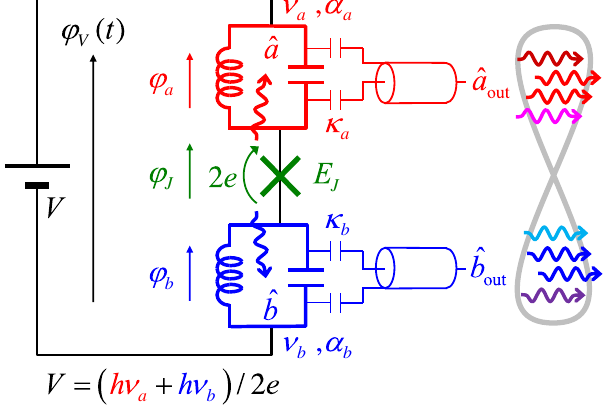
FIG. 1. Principle of the experiment. A simple superconducting circuit made of a Josephson junction (green cross, Josephson energy E ) in series with two microwave resonators (red and blue J LC circuits) having different frequencies ν , similar coupling a;b α to the junction (see text), and similar energy leak rates κ , is a;b a;b dc biased by a voltage source V . Phases φ entering the circuit Hamiltonian are also indicated. At a particular voltage (indicated at the bottom), each Cooper pair 2 e passing through the junction (green arrow) creates in a coherent way a pair of photons (vertical red and blue wiggles) in the two resonators; entangled microwave fields a and b grow in the resonators, as well as two stationary entangled microwave beams a and b . By measuring corre- out out t Þ and b t Þ , we experimentally demon- lations between a out ð out ð strate this